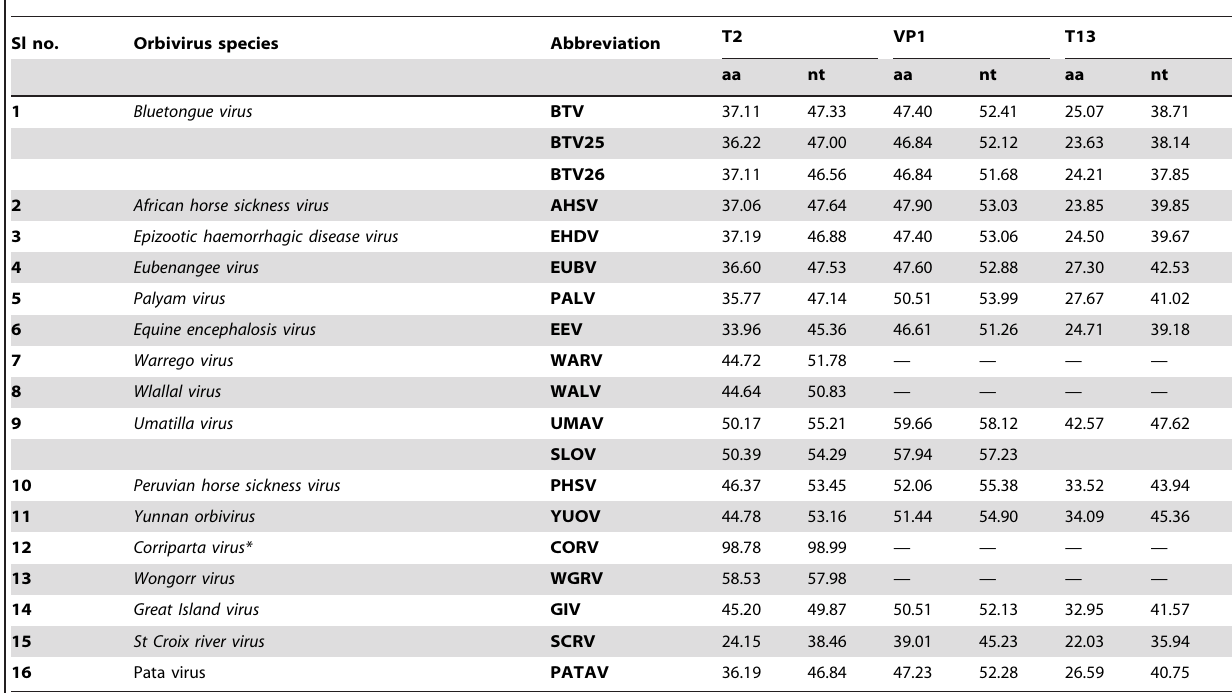
Table 3. Percent nucleotide (nt) and amino acid (aa) identities of Corriparta virus MRM1(AUS1960/01) with other orbiviruses.